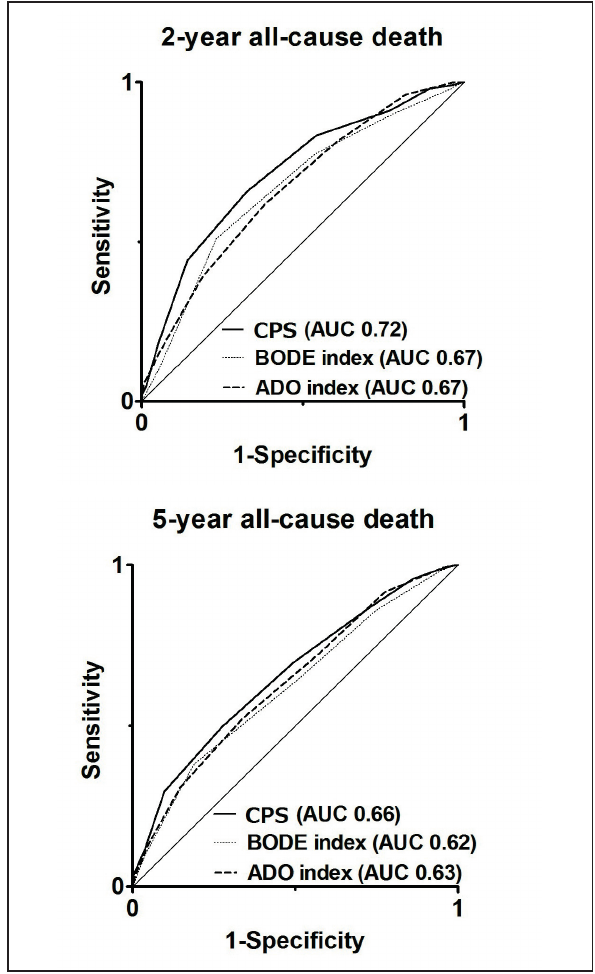
Fig. 2. Receiver operating characteristic curve for two-year and five-year all-cause